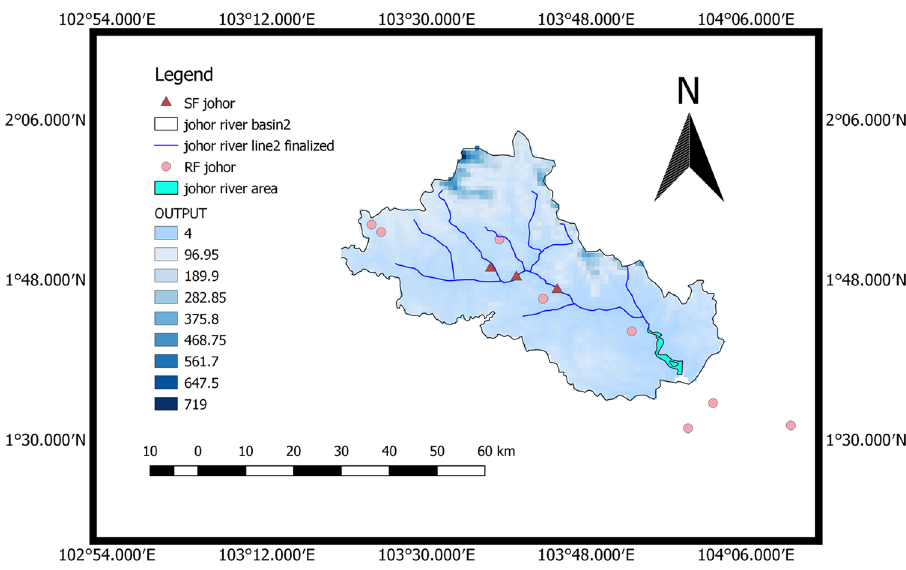
Fig. 2 Location of Johor River